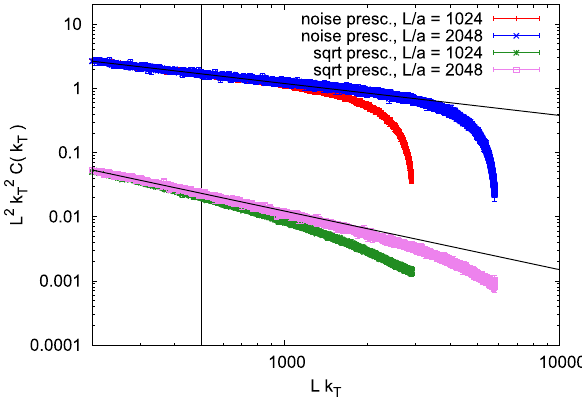
Fig. 18 Large k T L dependence of the evolved gluon distribution for different implementations and running coupling prescriptions at s = ˜ C ( Lk ) = a ( Lk ) b , is fitted to the data 0 . 16. A power law, ( L / a ) 2 k 2 T T T on the left of the vertical black line, with a and b being fit parameters. The fitted exponent b is around − 0 . 5 ( − 1) in the case of the “noise” (“square root”) prescription. In order to increase the figure readability, the “square root” data were divided by a factor